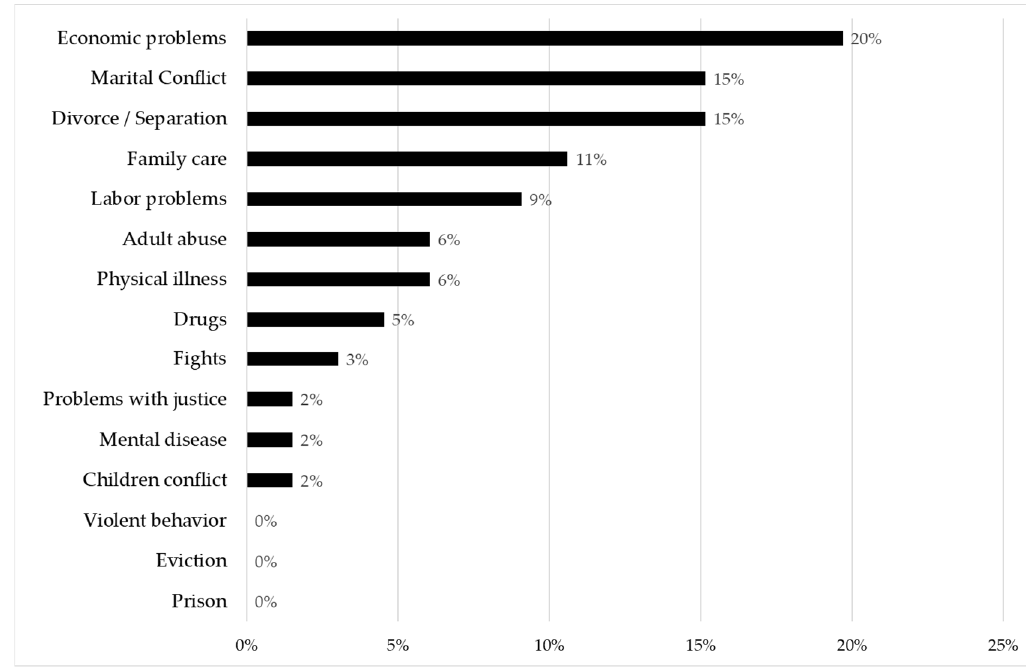
Figure 1. Actual negative or stressful life events.